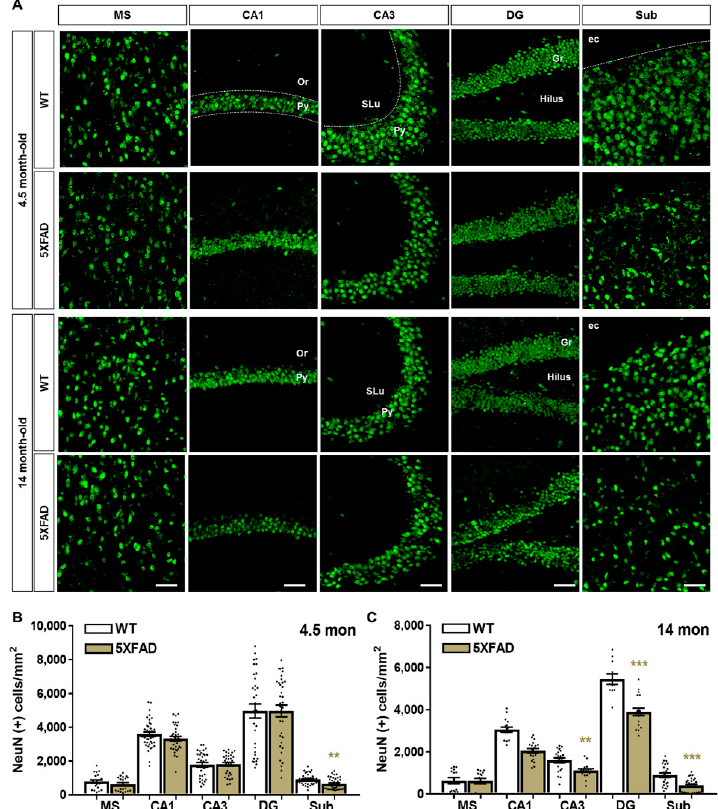
Figure 2. Neuronal loss in the MS and hippocampal formation of 5XFAD mice. ( A ) Neuronal nuclei (NeuN) were visualized using anti-NeuN antibody in the MS and hippocampal formation of wild-type (WT) and 5XFAD mice at 4.5 and 14 months of age. ( B , C ) The number of NeuN-positive cells per mm 2 was calculated in the 4.5- and 14-month-old WT and 5XFAD mice. Scale bar = 100 µ m. ** p < 0.01 and *** p < 0.001 indicate significant differences between the groups. Or, oriens layer; Py, pyramidal tract; SLu, stratum lucidum; Gr, granular layer; Mo, molecular layer; ec, external capsule (n = 20–35 images/group).